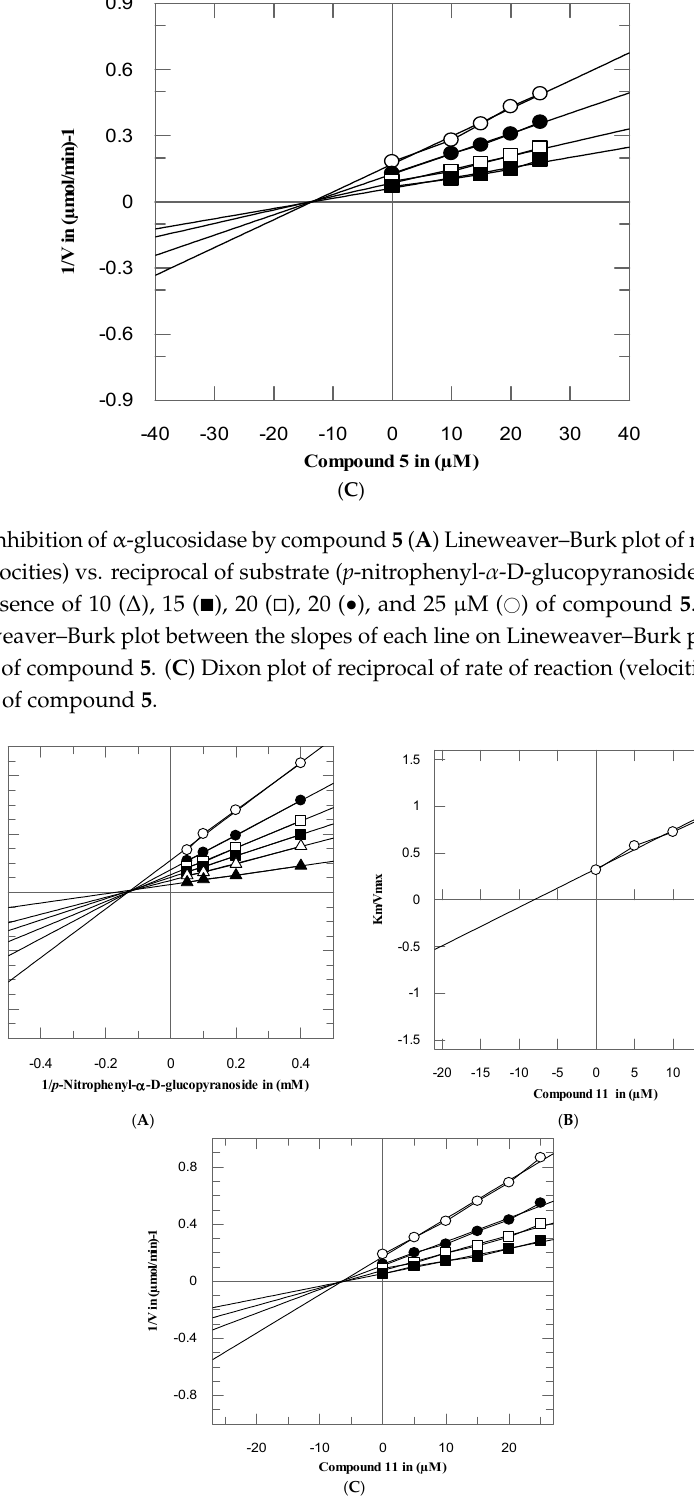
) of compound 11 . ( B ) Secondary (cid:35)